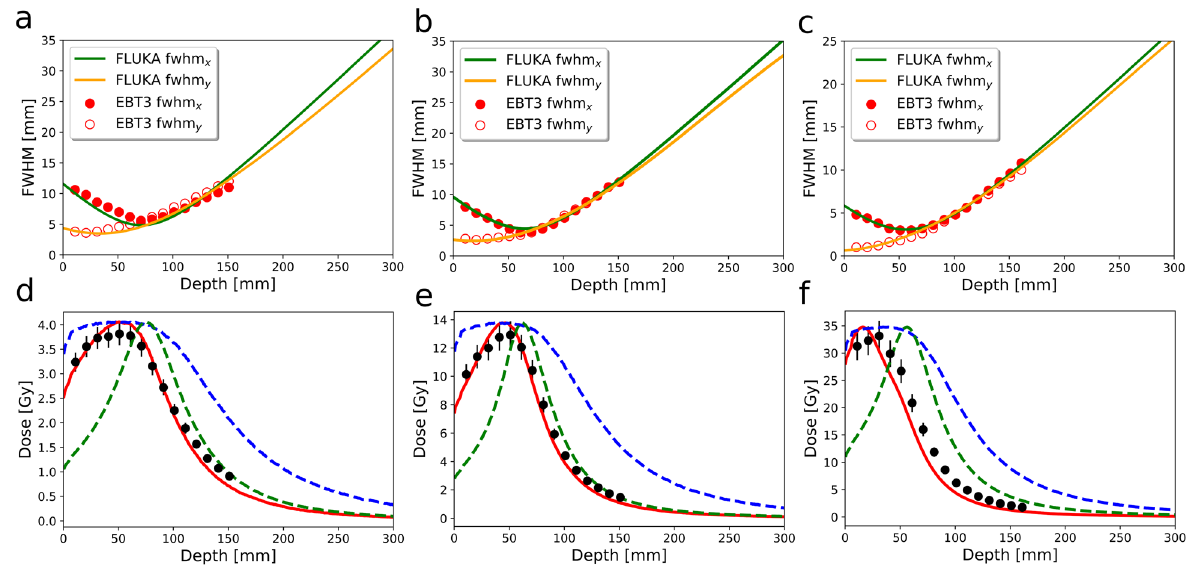
Fig. 4 Measured dose distributions. Beam envelope ( a – c ) and depth dose in the water phantom ( d – f ) for experimental focused beams. ( a , d ) 158 MeV focused with f/ 11.2, ( b , e ) 158 MeV focused with f/ 12.3, and ( c , f ) 201 MeV focused with f/ 18.2. Solid red curves are simulated depth – dose pro fi les for beams focused only in the horizontal plane. Dashed green lines are simulated dose pro fi les obtained for symmetric focusing, while the dashed blue lines represent collimated beams. The depth – dose curves for collimated and symmetrically focused beams are normalised to the peak dose of the line focus. The vertical lines in depth – dose pro fi le for experimental beam indicate measurement